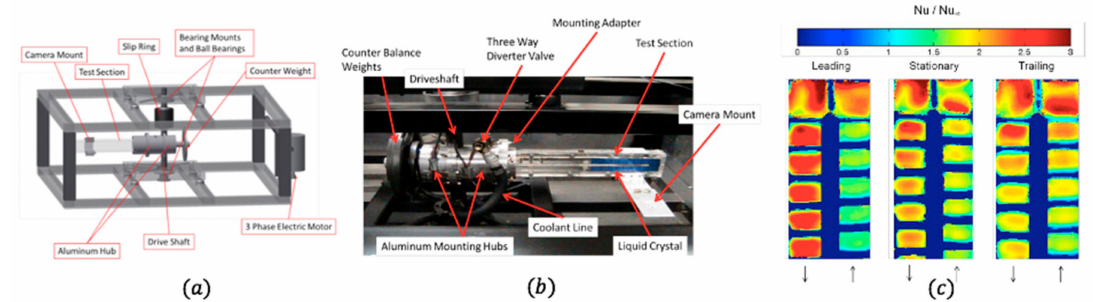
Figure 11. ( a ) Rotating heat transfer facility [40], ( b ) test section, ( c ) detailed Nusselt number ratio ( Nu / Nu 0 )